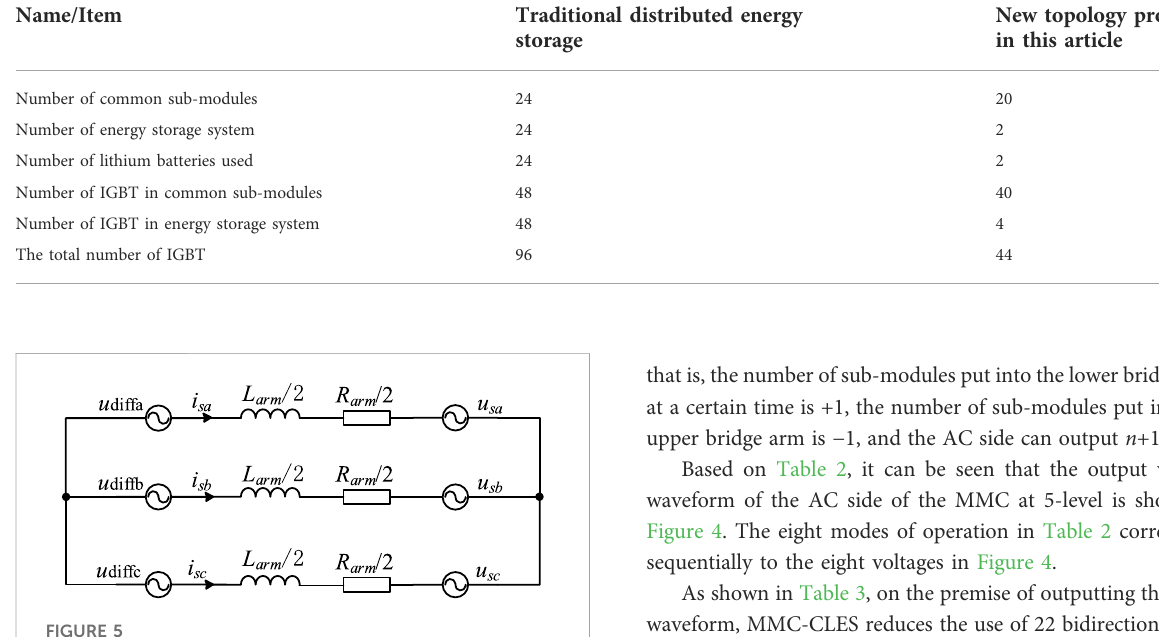
FIGURE 5 MMC-CLES equivalent